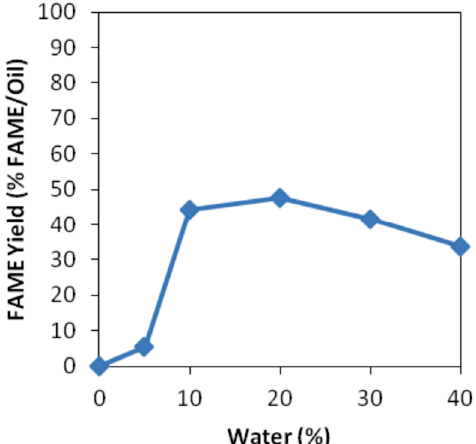
Fig. 5. Effect of water on FAME yield (0.28% lipase and 72 h reaction).